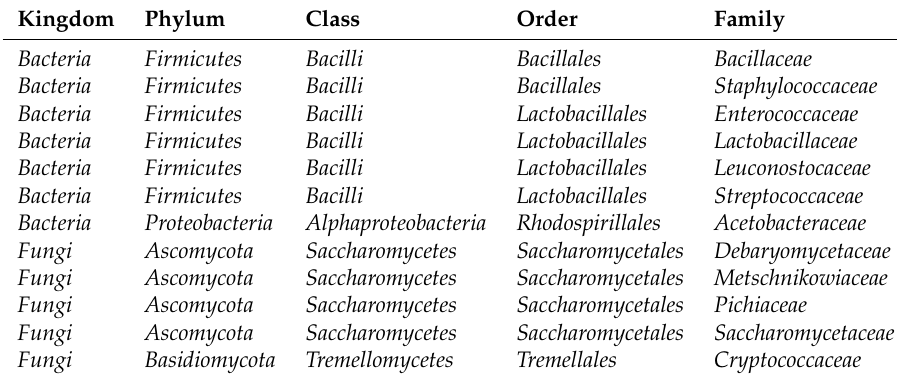
Table A3. Wine-related microorganisms